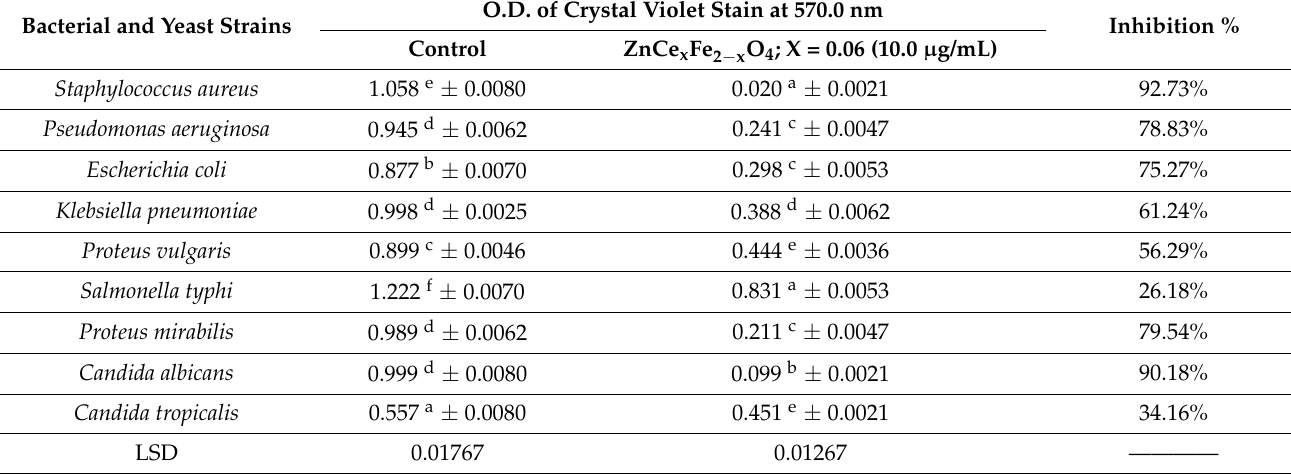
———— Values are means ± SD (n = 3). Data within the groups were analysed using one-way analysis of variance (ANOVA) followed by a,b,c,d,e,f Duncan’s multiple range test (DMRT) and LSD = least significant difference. Figure 8a displays the start of the tube design for the determination of the antibiofilm potential of ZnCe x Fe 2 − x O 4 ; X = 0.06 against S. aureus. This bacterium produced a